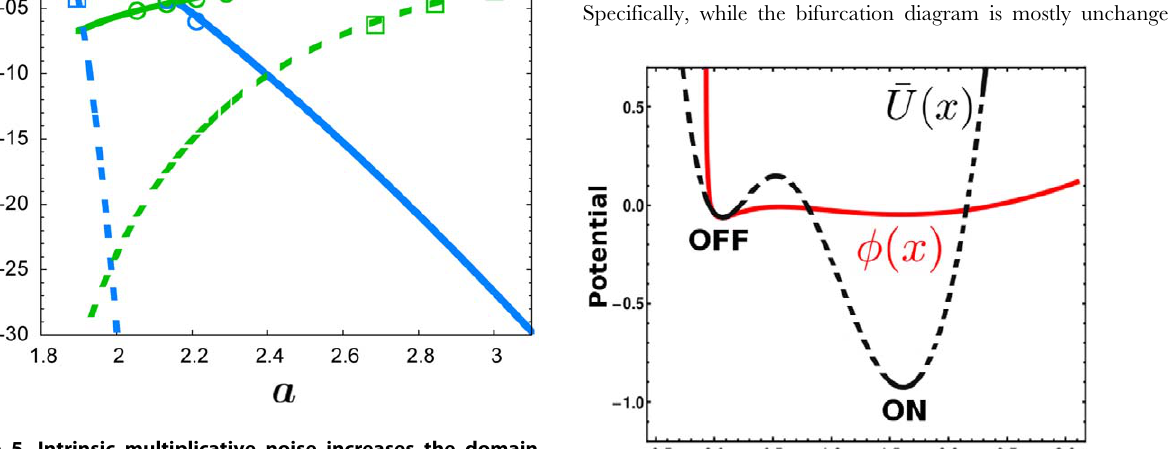
Figure 5. Intrinsic multiplicative noise increases the domain where the OFF state predominates. Switching rates for stochastic transitions from ON to OFF (blue) and viceversa (green) for the additive (dashed lines) and for the multiplicative (continuous lines) systems, Figure 6. Intrinsic multiplicative noise changes the relative computed from Eq (16). The critical value a c at which the switching ~ 1 : 99 in the stability of the ON state. Stochastic potential of the additive noise rates for the two transitions are equal is shifted from a add c ~ 2 : 16 for the multiplicative noise scenario. Results model (black dashed line, Eq (15)) and of the multiplicative noise additive case to a mult c scenario (red continuous line, Eq (10)) for a ~ 2 : 15 . As shown, the ON for Langevin simulations of the additive noise model (squares) and for state is clearly destabilized by multiplicative noise. This is also observed Gillespie simulations of the multiplicative noise model (circles) are for different values of a . depicted.